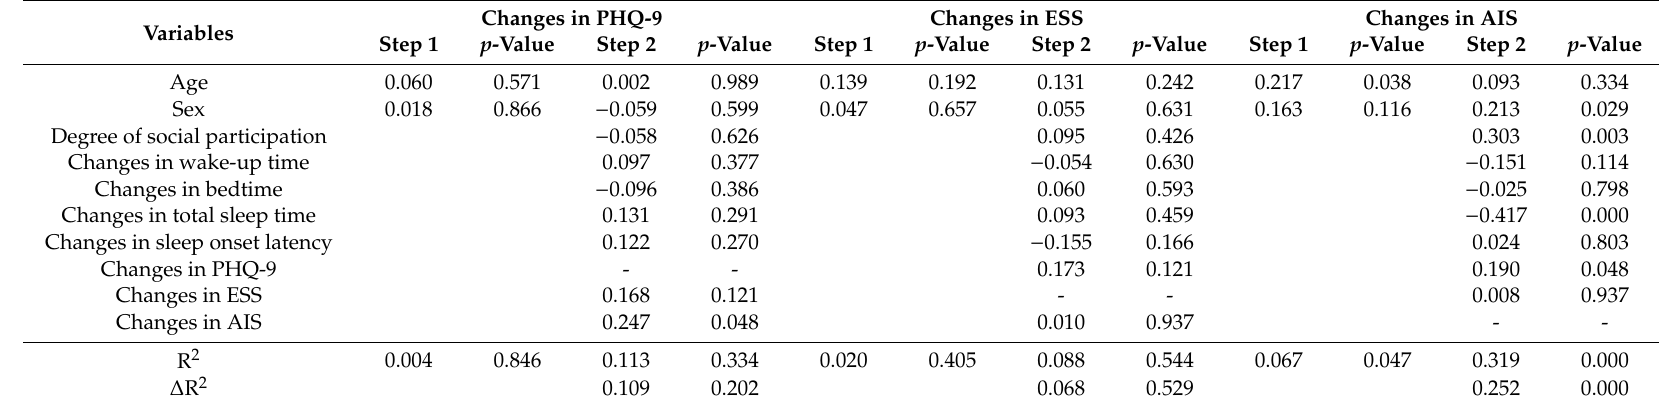
Table 3. Results of multiple regression analysis in the no / little self-isolation